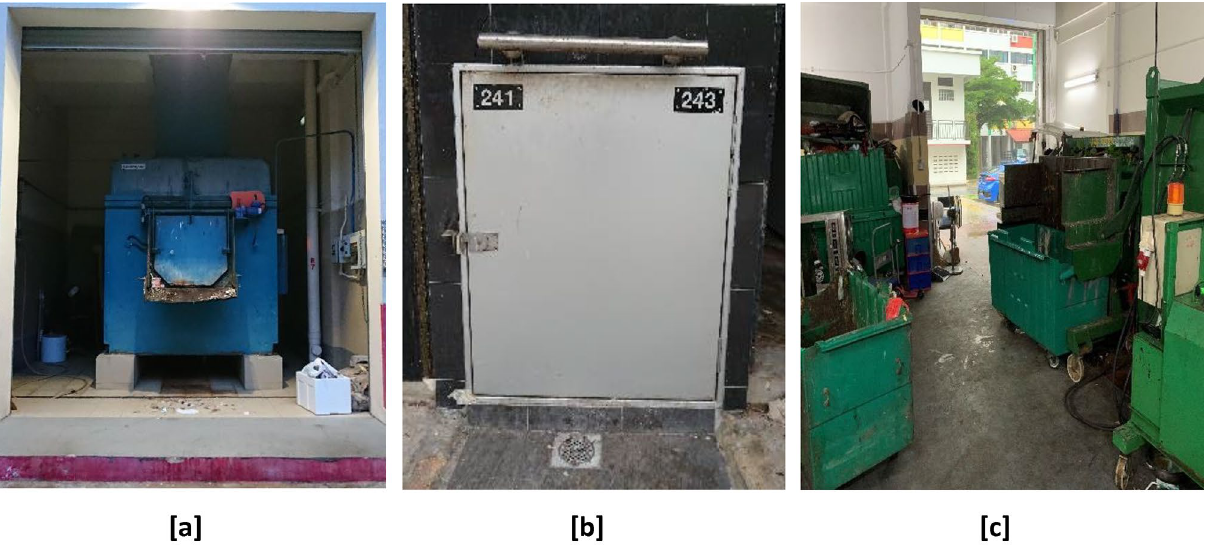
Figure 1. Waste collection premises in public housing estates in Singapore. ( a ) Central refuse chute room, ( b ) individual refuse chute bin chamber and ( c ) bulk waste bins within a refuse bin